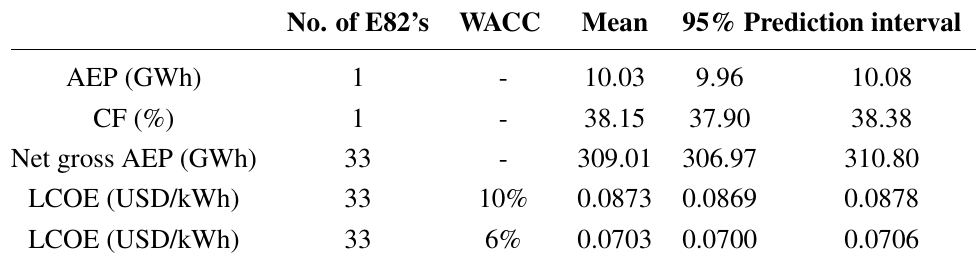
Table 10. AEP and levelized cost of energy (LCOE) results. WACC: weighted average cost of capital.